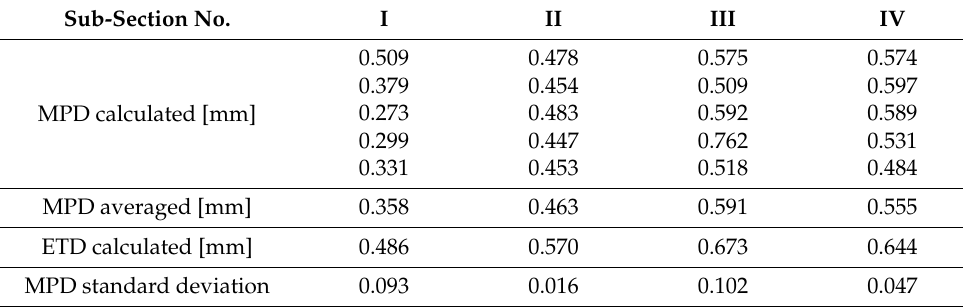
Table 5. MPD values calculated on extracted section segments.